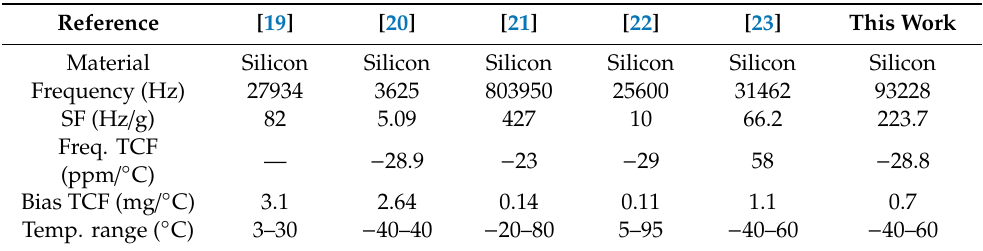
Table 3. Summary of comparison with previous